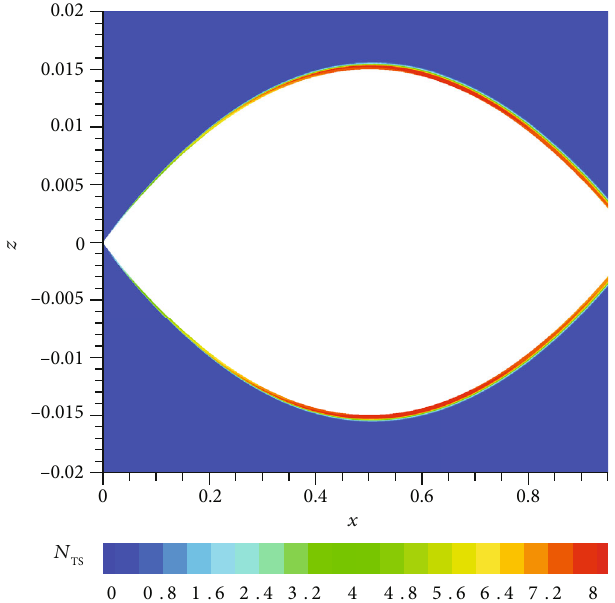
Figure 12: The predicted N